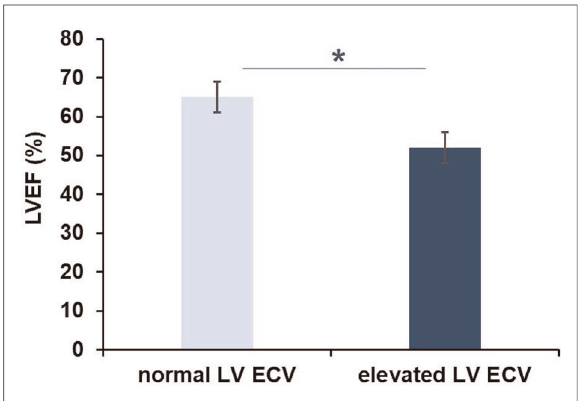
FIGURE 2 Extracellular volume and left ventricular function in transposition of the great arteries. Patients with elevated left ventricular extracellular volume (LV ECV) had signi fi cantly lower LV ejection fraction (LVEF) than patients with normal LV ECV (52±5 vs. 65±4%; * p